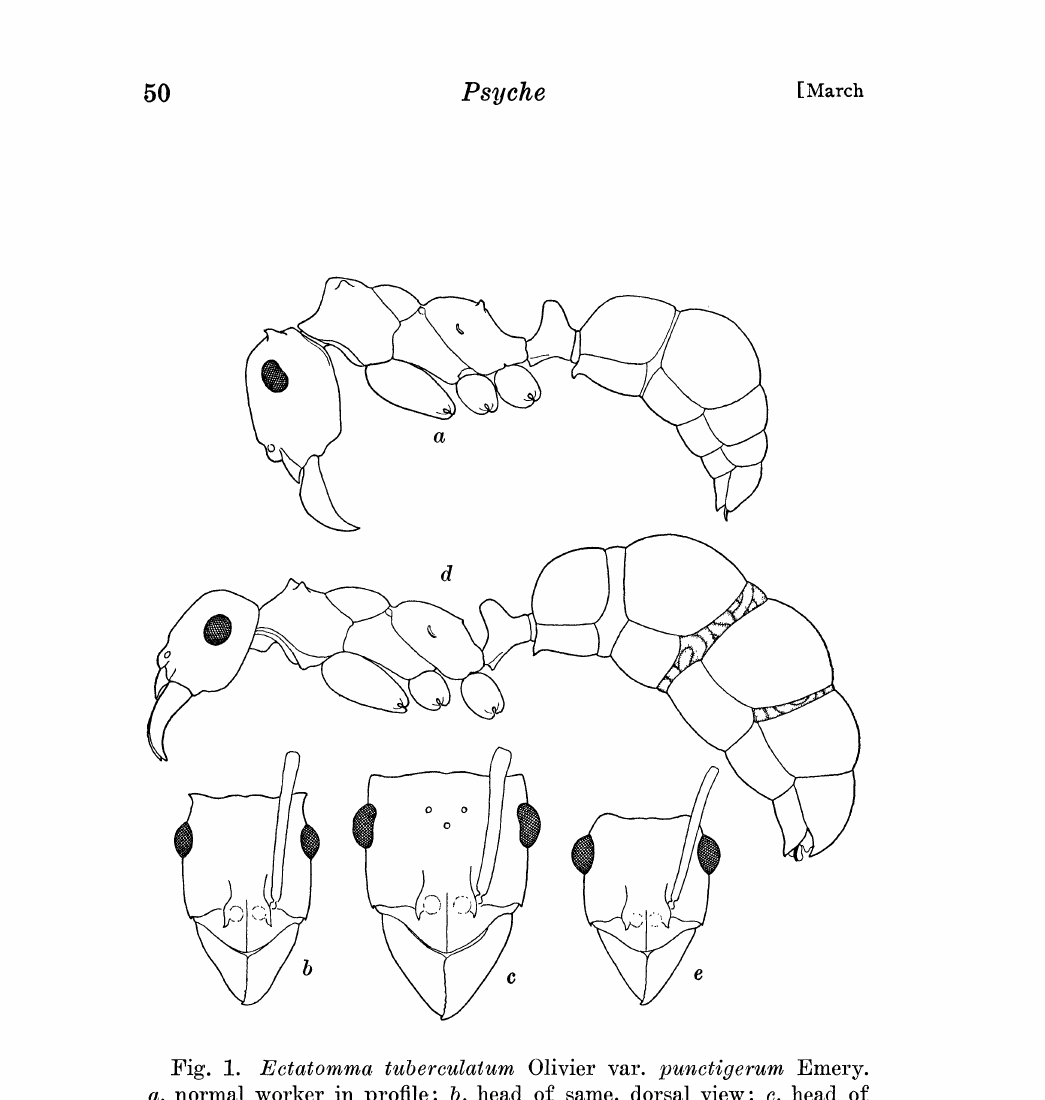
Fig. 1. Ectatomma tuberculatum Olivier var. punctigerum Emery. a, normal worker in profile.; b, head of same, dorsal view; c, head of normal female; d, mermithergate in profile; e, head of